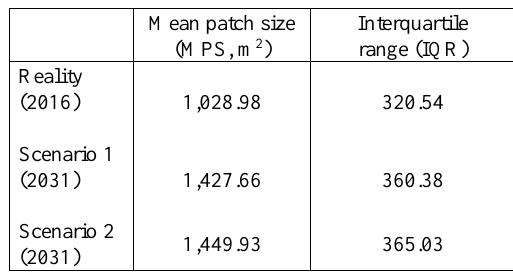
Table 4 . Mean value and standard deviation of patch